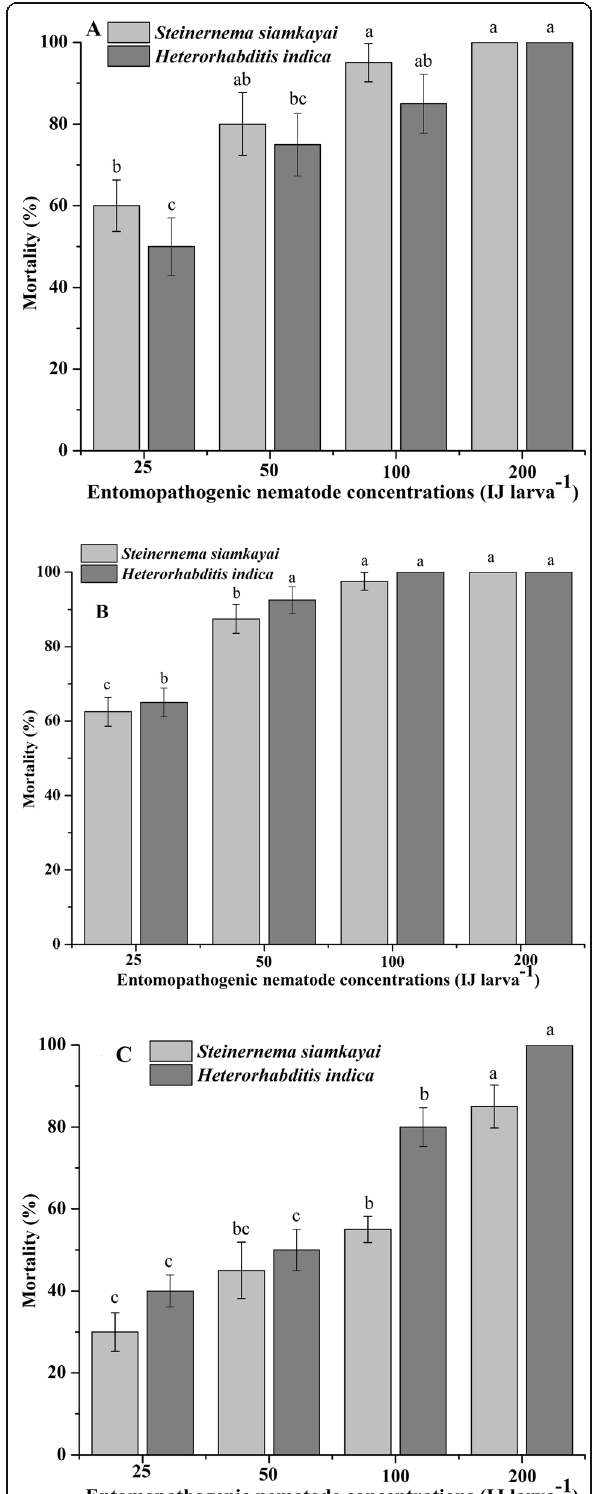
Fig. 3 Percent mean mortality of 3 rd instar larvae of a Spodoptera litura , b Spilosoma obliqua , c Spoladea recurvalis at different concentrations of entomopathogenic nematodes, Steinernema siamkayai (IIVR JNC01 strain), and Heterorhabditis indica (NBAIIH38 strain) at 2 days after treatment. Different letters on the top of error bars indicate statistically different values for different nematode concentrations at ( P < 0.05) using Tukey ’ s test. Bars = standard error ( n =